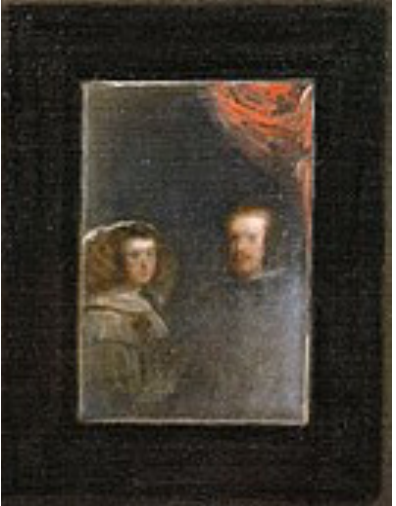
Figure 6. Detail, mirror (Velázquez 1656).